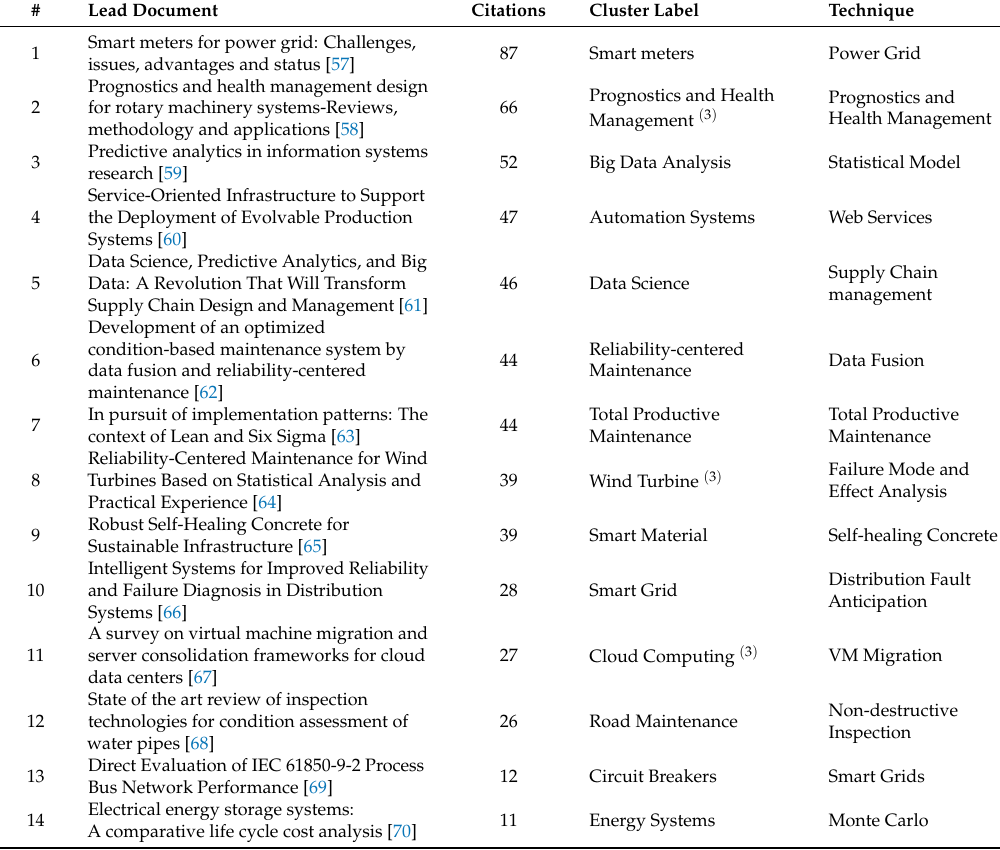
Table 7. Research Front